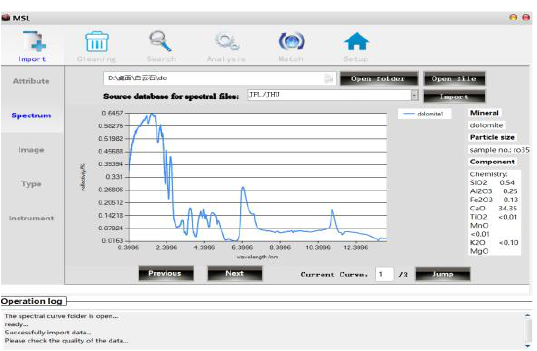
Figure 12. The data analysis interface